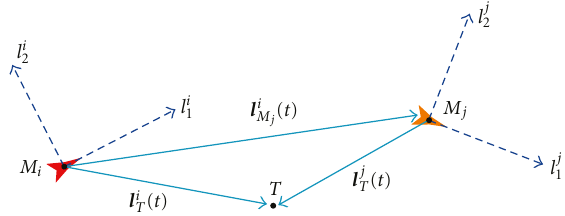
Figure 2: Two agents, M i and M j , whose respective local coordinate systems are specified by the l k 1 and l k 2 axes ( k ∈ { i , j } ). The displacements from each agent to the common target T , that is, ( k ∈ { i , j } ), as well as the displacement from M i to M j , that is, l k T , are shown. l i M j